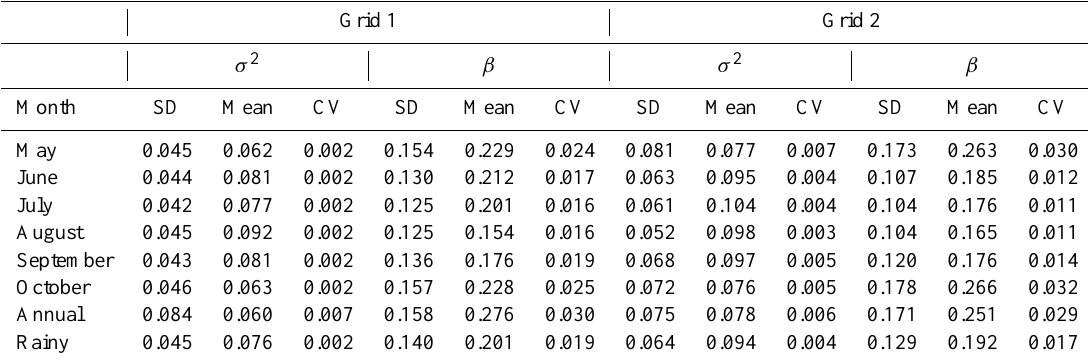
Fig. 9. Graph presents the relation of model parameters ( β , σ 2 ) with average rainfall (a) grid 1- β , (b) grid 1- σ 2 , (c) grid 2- β , and (d) grid 2- σ 2 . Table 2. Statistics of estimated parameters for random cascade